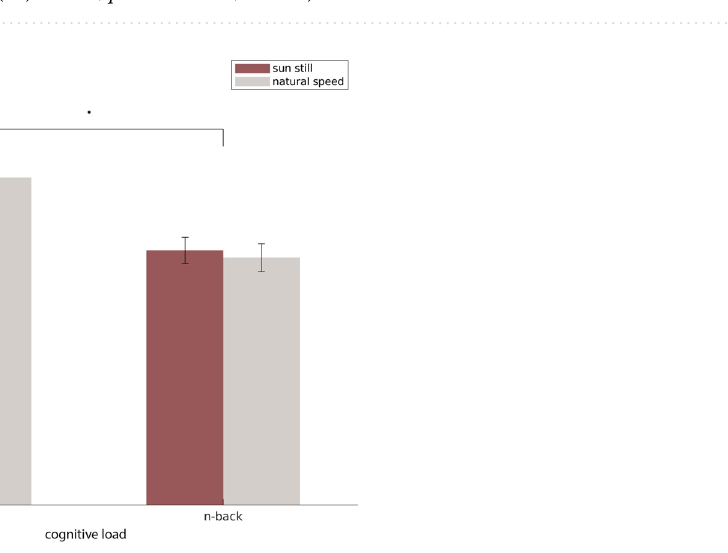
Figure 1. Mean duration estimation for each experimental condition. Error bars indicate SEM. We found no significant effect of sun ( A ) nor immersion ( C ). We found a significant effect of cognitive load ( B ). Post-hoc tests indicated that subjects estimated time to be shorter in the condition with an n-back task compared to the condition with no task ( t (36) = 8 . 307 , p = 6 . 876 e − 10 ,d = 0 . 59).